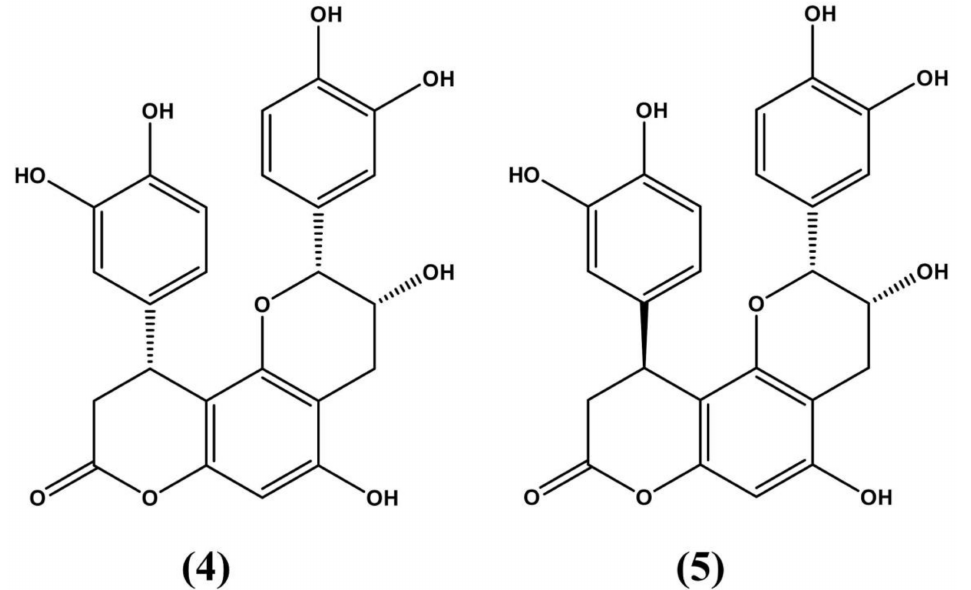
Figure 3. Cinchonains 1a ( 4) and 1b ( 5 ) as reported in Satoh et al. (2000)